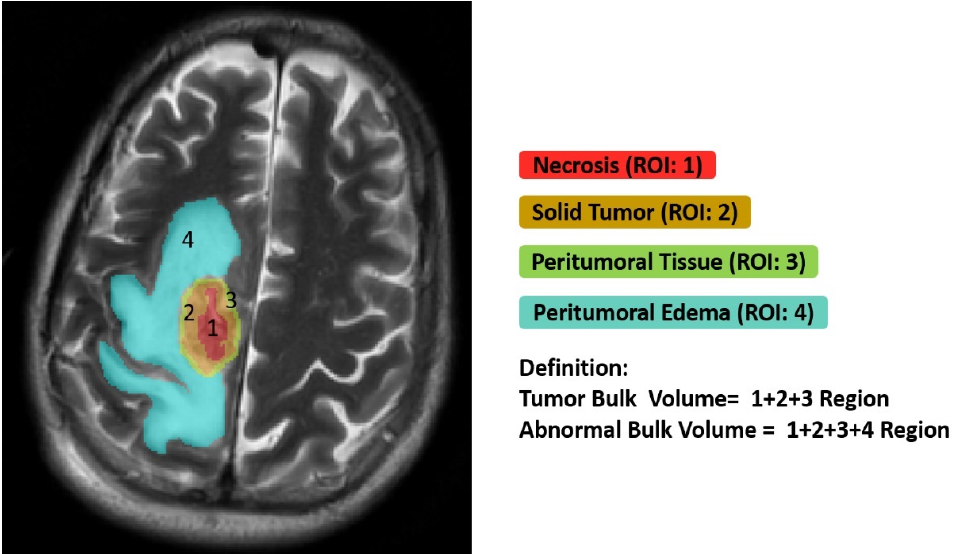
Figure 2. GBM derived from T1-CE MR images for individual measurement in specific necrosis, solid part tumor, peritumoral tissue, and edema regions of right-side frontal lobe volume in a subject. TBV represents the addition of these tumor features. The ABV is represented by hyperintensity extracted from T2-FLAIR images. Edema is the difference of tumor bulk from abnormal bulk